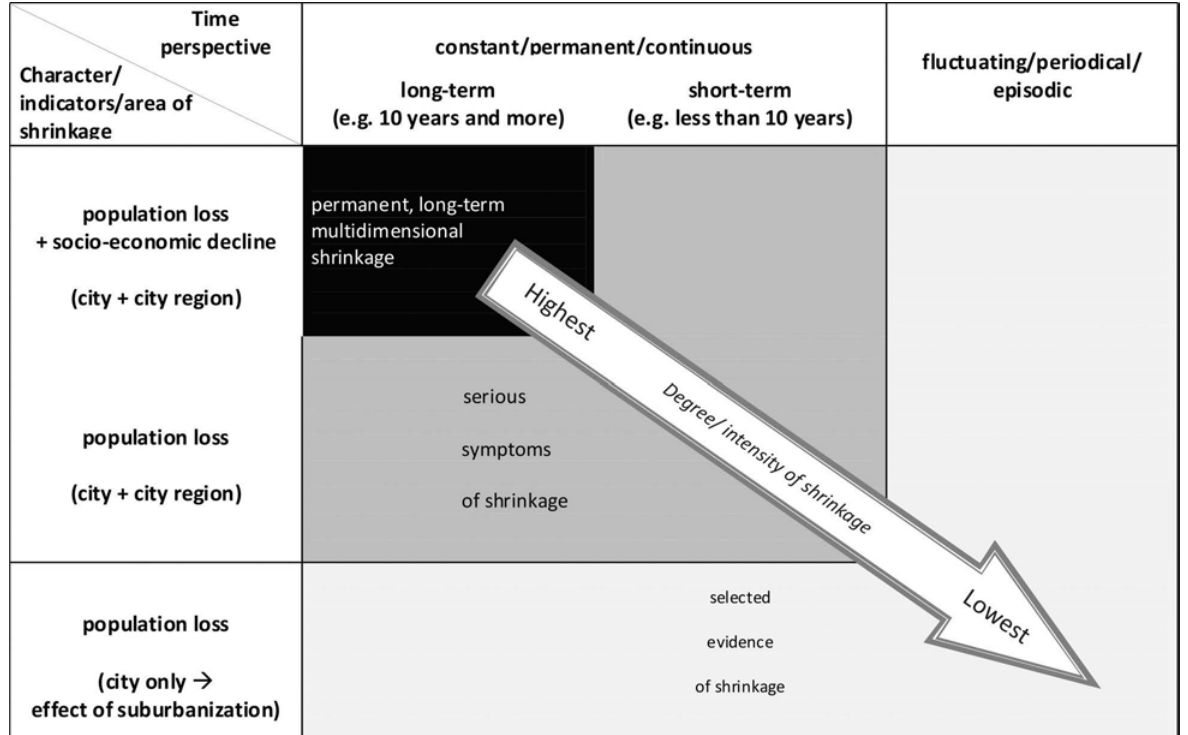
Fig. 1. Typology of shrinking cities – ‘graduation’ of shrinkage. Source: Stryjakiewicz (2013: